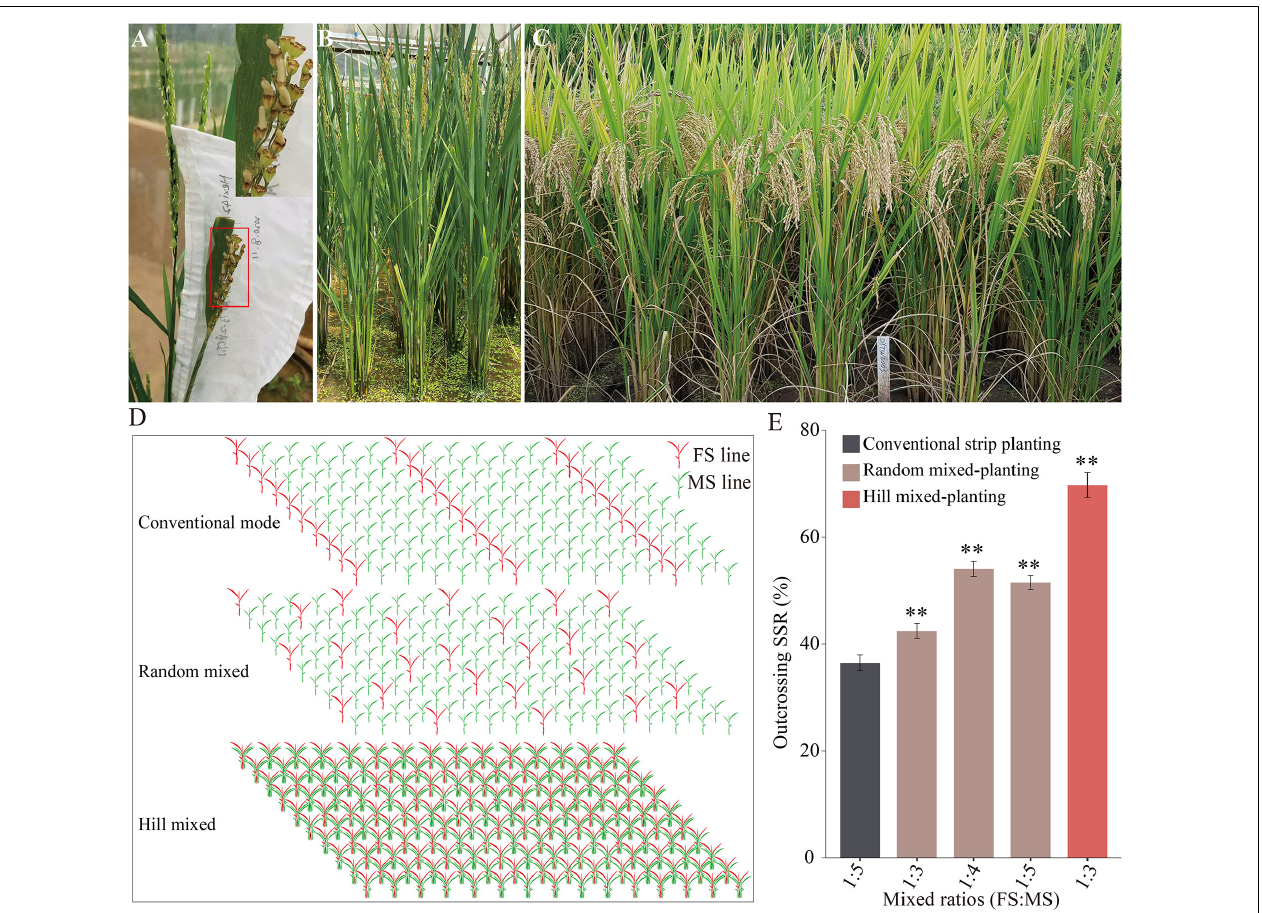
FIGURE 4 | HRS production is based on the FM-line system. (A) The seed setting of the maternal ‘Hexi42A’ plant is pollinated by pollen from the transgene-free FS line 319FS. (B) Morphology of transgene-free FS line 319FS. (C) Plant-type and heterosis observations of the hybrid F 1 generation of Hexi42A/319FS. (D) Diagram of the FM-line system using three different mixed-planting methods for HRS production. (E) Statistical data of the outcrossing SSR of the maternal plants in HRS production using the FM-line system. The data are presented as means ± SDs ( n = 100), and a statistical analysis using t -tests indicated the significant differences ( ∗∗ p < 0.01). HRS, hybrid rice seed; SSR, seed setting